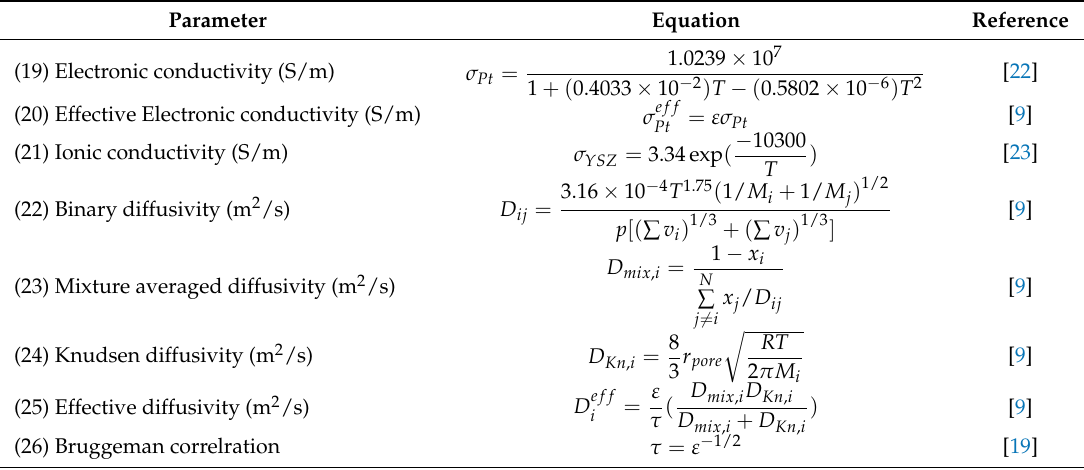
Table 1. Constitutive equations for transport parameters.